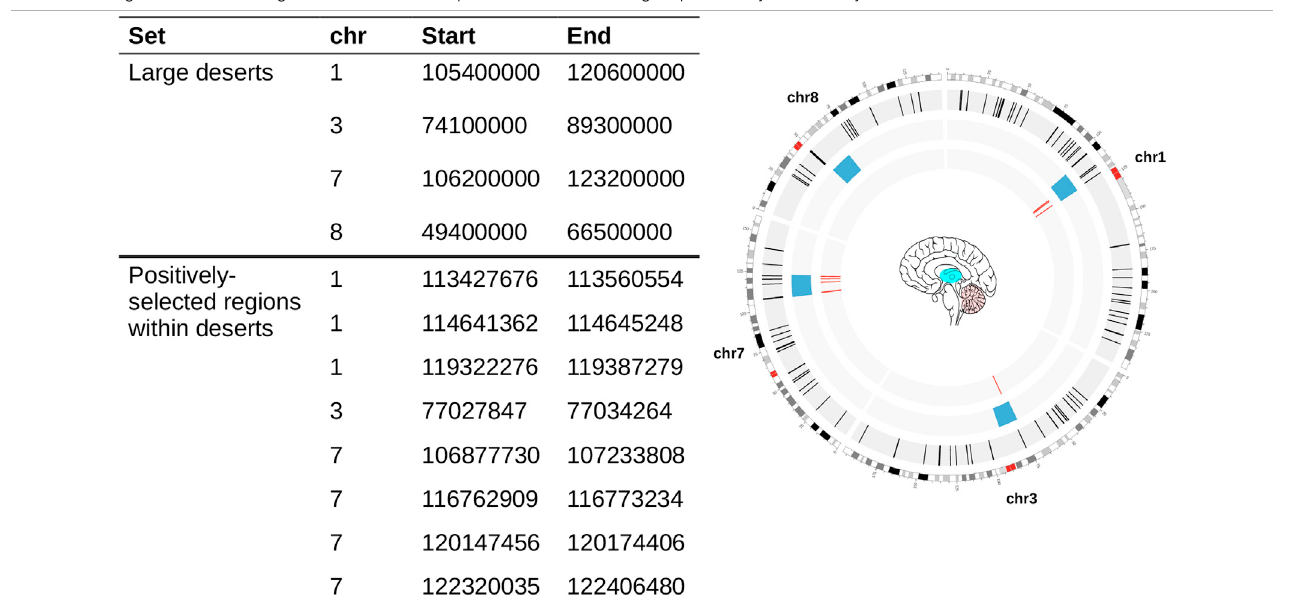
TABLE 1 | Genomic coordinates used in this study. Large deserts were retrieved from (Chen et al., 2020), and positively-selected regions from (Peyrégne et al., 2017) (see Section4 ).Thecircosplotontherightshowsthedistributionofourregionsofinterest:Bluebloxes:desertsofintrogression;Redlines:positively-selectedregionswithin deserts of introgression. Colored regions within the brain represent structures that fi gure prominently in this study.